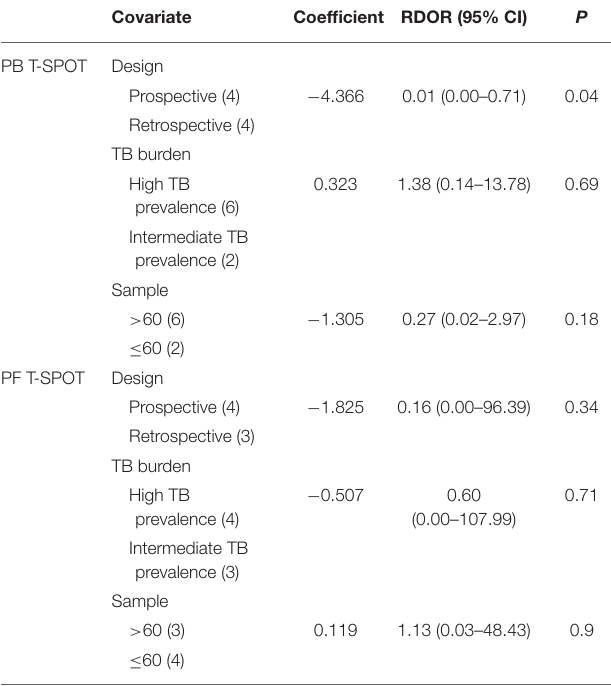
TABLE 3 | Weighted meta-regression to assess the effects of various factors on diagnostic accuracy of T-SPOT assay.